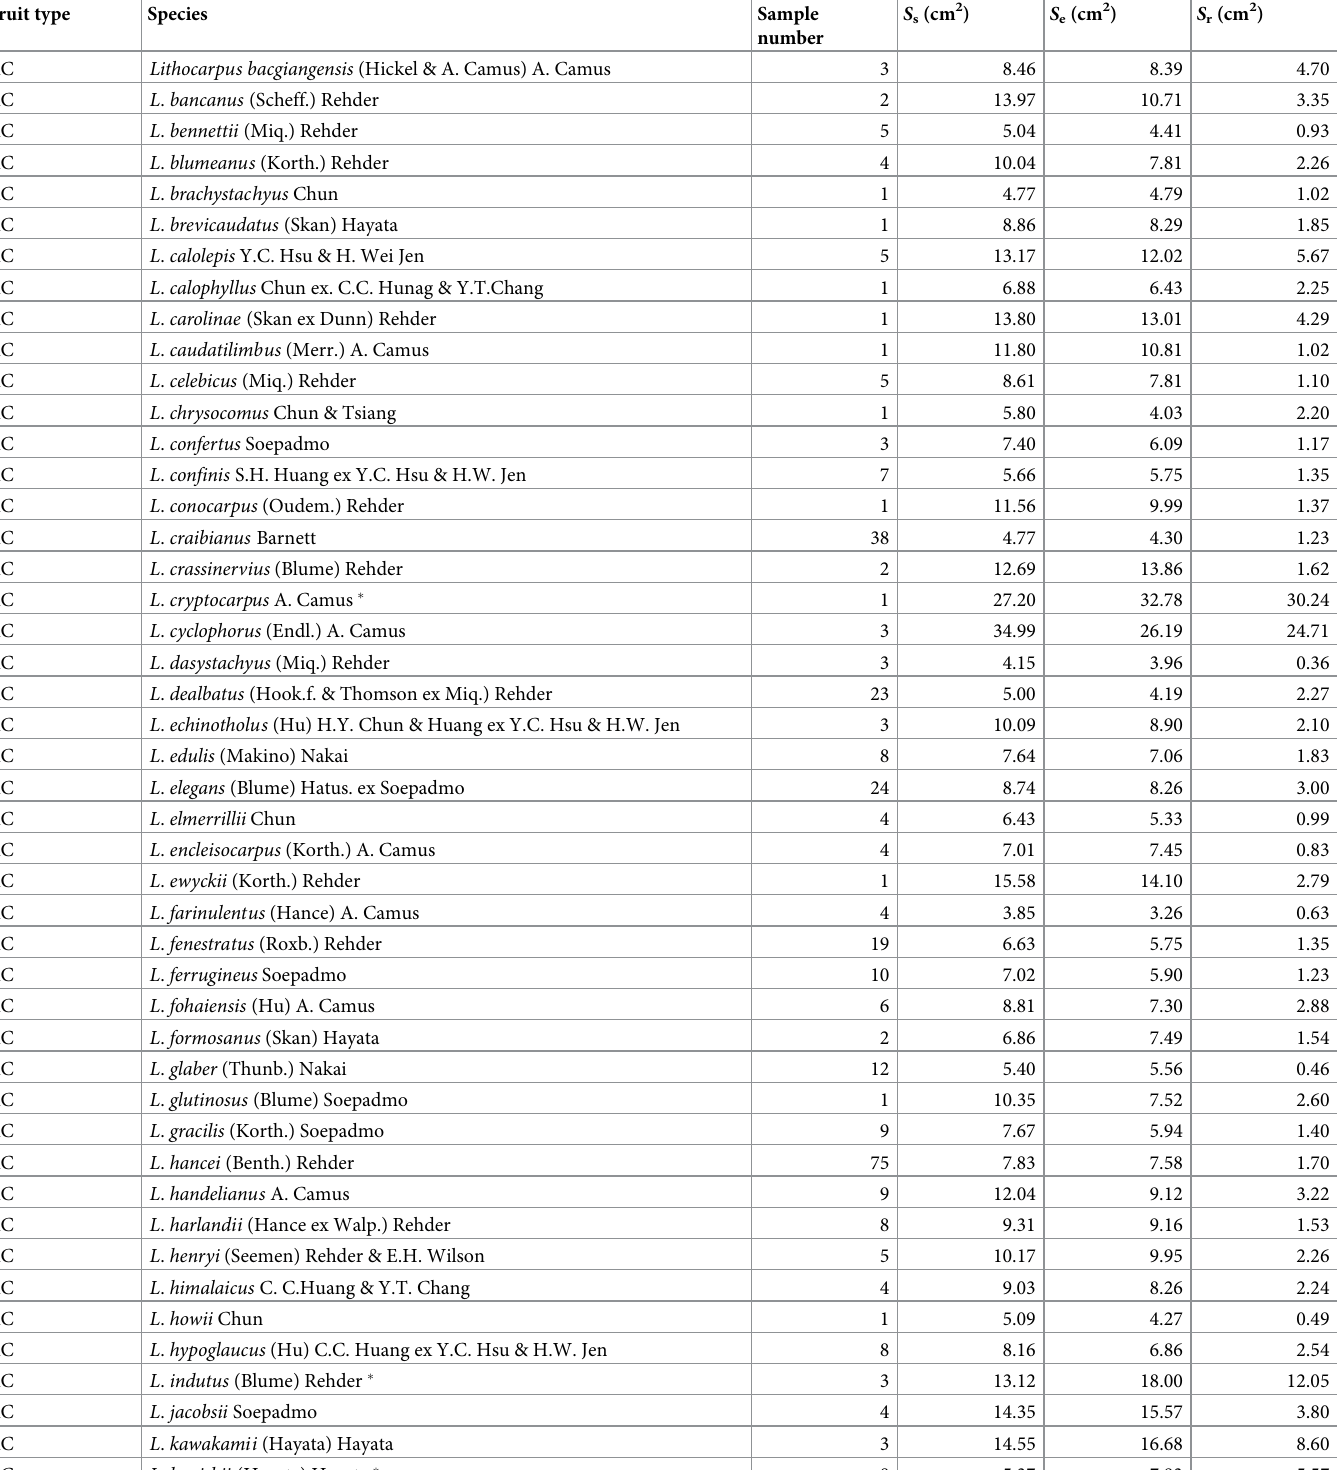
Table 1. The fruit type classification based on the species average seed coverage by exocarp and receptacle. Fruit